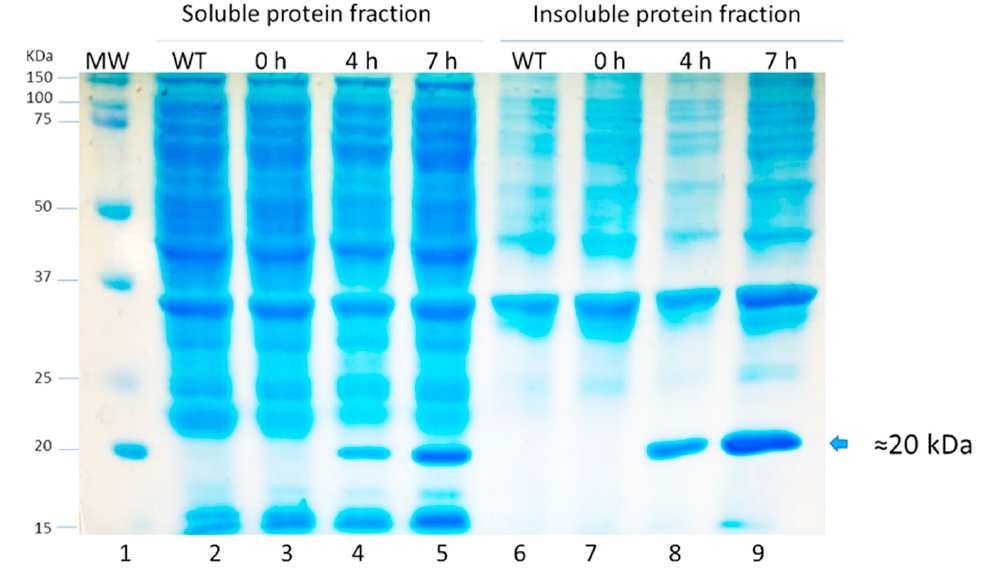
Figure 3. SDS-PAGE analysis of protein extracts from cultures expressing LTB-RBD Wuhan induced for 4 and 7 h at 28 °C with lactose (lanes 2 to 5: soluble protein fraction and lanes 6 to 9: insoluble protein fraction). Lane 1: molecular weight marker, lanes 2 and 6: untransformed cultures, lanes 3 and 7: uninduced cultures, lanes 4 and 8: cultures induced for 4 h, and lanes 5 and 9: cultures induced for 7 h.